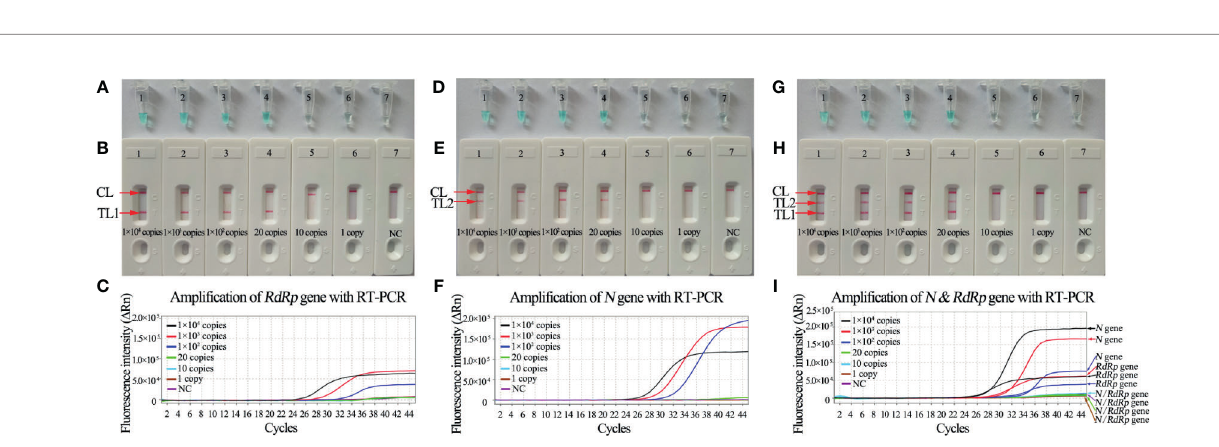
FIGURE 5 | Sensitivity analysis of RdRp -, N -, and mRT-LAMP detection with serial dilutions of RNA extracted from pseudo-virus SARS-CoV-2. The LoD of RT- LAMP for detecting SARS-CoV-2 was analyzed with visual detection reagents (MG) and lateral fl ow biosensors. (A, B) Sensitivity analysis of RdRp -RT-LAMP reaction. Tubes A1-A7 (Biosensors B1-B7) represent the genomic RNA amounts of 1×10 4 copies, 1×10 3 copies, 1×10 2 copies, 20 copies, 10 copies, and 1 copy per reaction and blank control (DW), respectively. The LoD of RdRp -RT-LAMP detection was 20 copies of RNA template per reaction. (C) Sensitive of RdRp -RT- PCR detection (1×10 4 copies to 1 copy). The LoD of RdRp -RT-PCR detection was 100 copies of RNA template per reaction. (D, E) Sensitivity analysis of N -RT- LAMP reaction. Tubes D1-D7 (Biosensors E1-E7) represent the genomic RNA amounts of 1×10 4 copies, 1×10 3 copies, 1×10 2 copies, 20 copies, 10 copies, and 1 copy per reaction and blank control (DW), respectively. The LoD of N -RT-LAMP detection was 20 copies of RNA template per reaction. (F) Sensitive of N -RT-PCR detection (1×10 4 copies -1 copy). The LoD of N -RT-PCR detection was 100 copies of RNA template per reaction. (G, H) Tubes G1-G7 (Biosensors H1-H7) represent the genomic RNA amounts of 1×10 4 copies, 1×10 3 copies, 1×10 2 copies, 20 copies, 10 copies, and 1 copy per reaction and blank control (DW), respectively. The LoD of the mRT-LAMP assay for RdRp and N detection was 20 copies of RNA template per reaction. (I) Sensitive of mRT-PCR detection (1×10 4 copies to 1 copy). The LoD of mRT-PCR detection was 100 copies of RNA template per